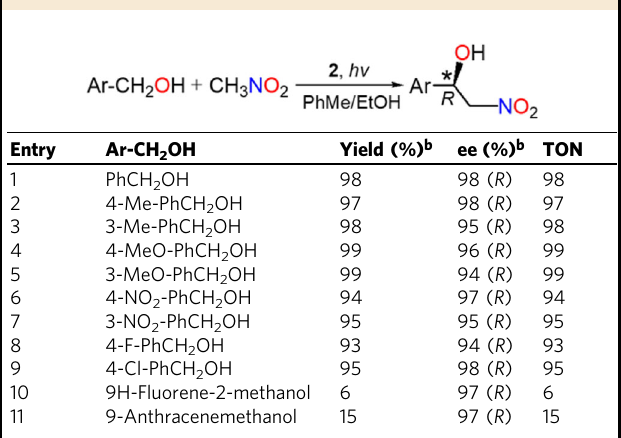
Table 2 Scope of the 2-catalyzed one-pot asymmetric Henry reactions